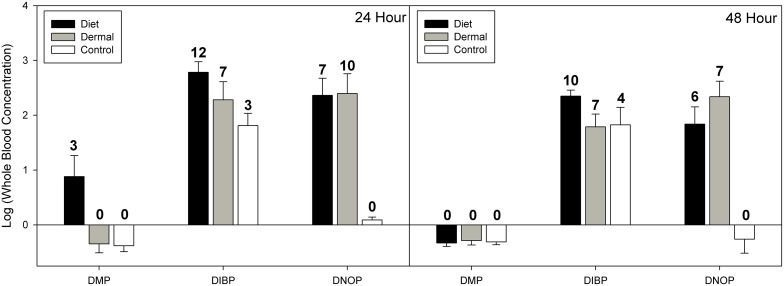
Phthalate concentrations in western fence lizard blood samples at 24 and 48 hour time points.Data for 24 hours and 48 hours are presented as log10 means (ng/g ± SE). Phthalate congeners are: di-methyl phthalate (DMP), di-iso-butyl phthalate (DIBP), and di-n-octyl phthalate (DNOP). Linear mixed effects model suggests significant effects of exposure route (χ2 = 31.71, df = 2, p<0.001) and phthalate congener (χ2 = 140.3, df = 2, p<0.001), and a significant effect of time (χ2 = 7.16, df = 2, p = 0.007). See text for complete statistical information. Numbers above error bars indicate the number of detections out of 12 samples. At 24 hours, 1 dermal treatment sample was lost during extraction and, therefore, detections listed are out of 11 samples.